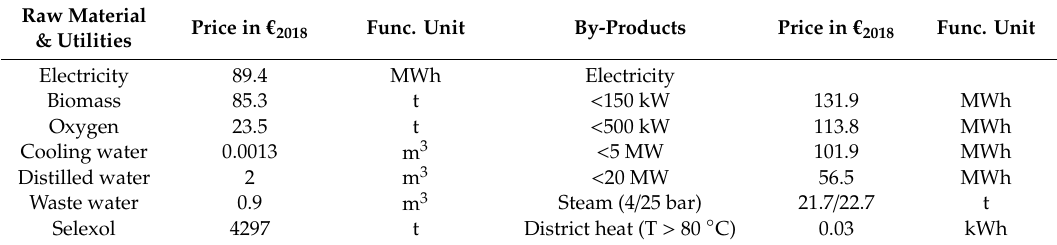
Table 2. Assumed raw material and utility costs and revenues from by-products; data adapted from